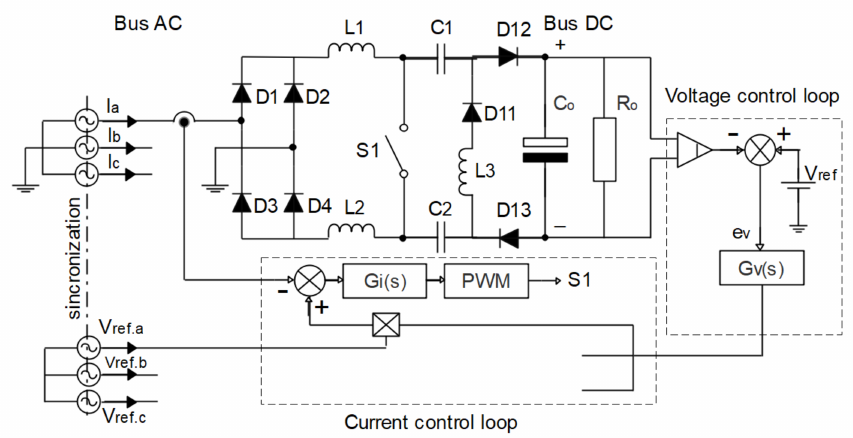
Figure 7. Modular three-phase rectifier with SEPIC